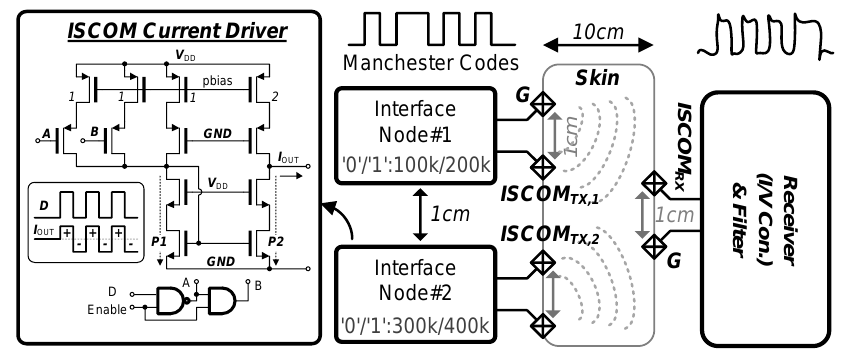
Figure 11. Intra-skin communication (ISCOM) configuration and current driver circuit.